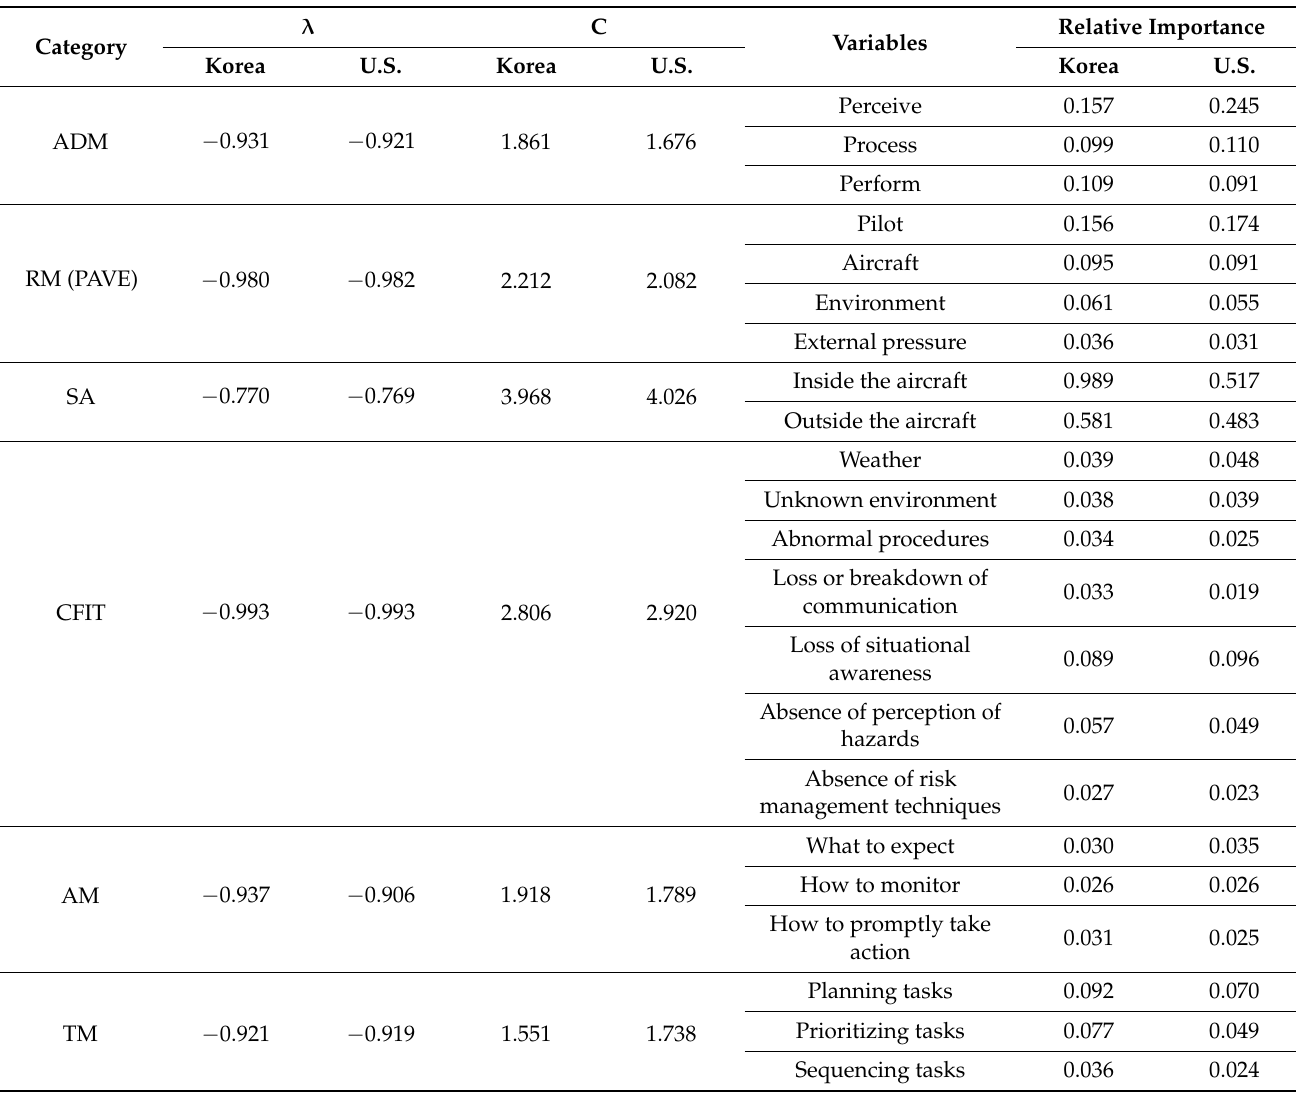
Table 5. Composite Importance of SRM Category and Variables using Integral Fuzzy